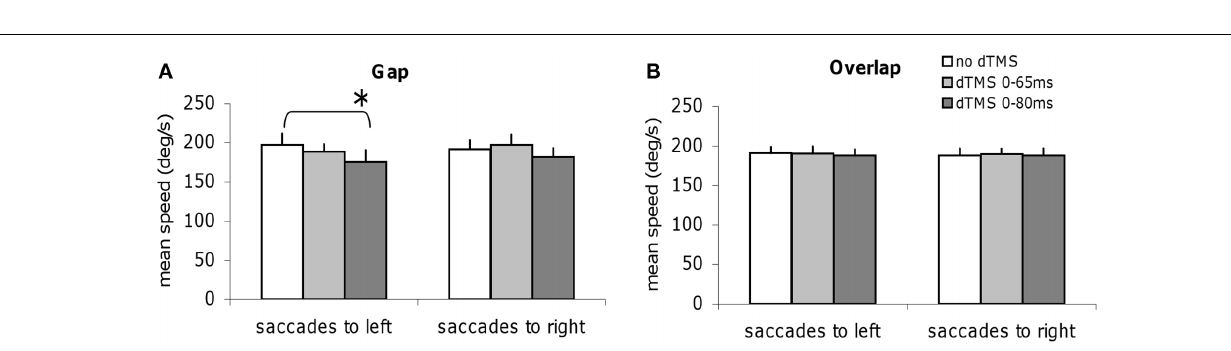
FIGURE 5 | Coefficient of variation of saccade latencies for the group subjects in different dTMS conditions: no dTMS, dTMS 0–65ms, dTMS 0–80ms under the tasks gap (A) and overlap (B). Asterisks indicate a significant effect on group mean values of dTMS with an ISI of 65 or 80ms versus control no dTMS.